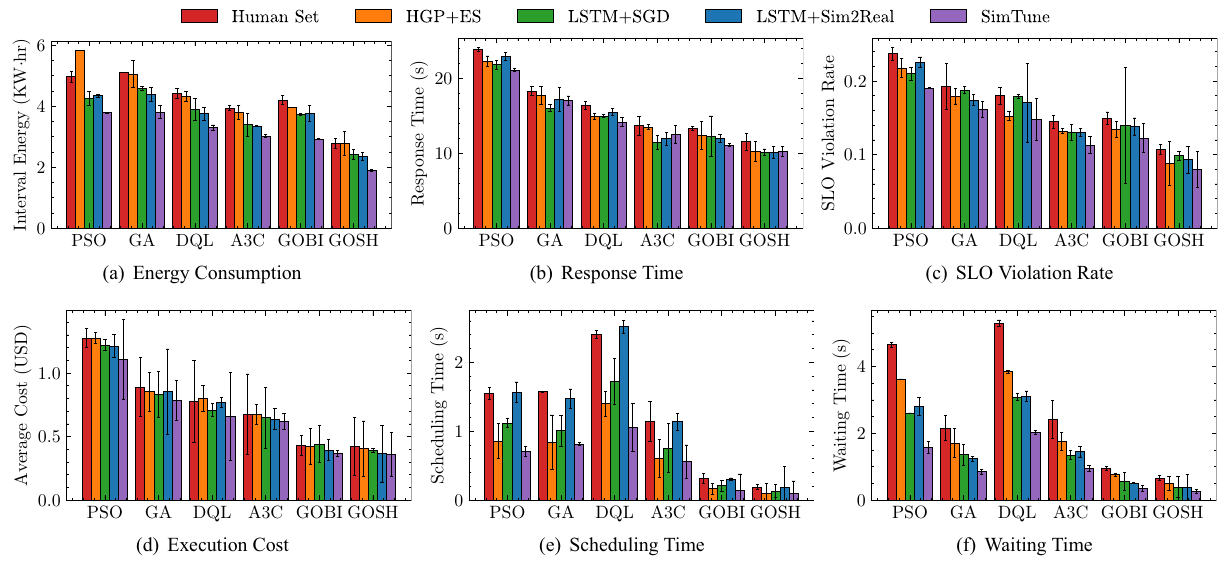
Figure 4. Comparison of QoS parameters (averaged over intervals) of SimTune against baseline